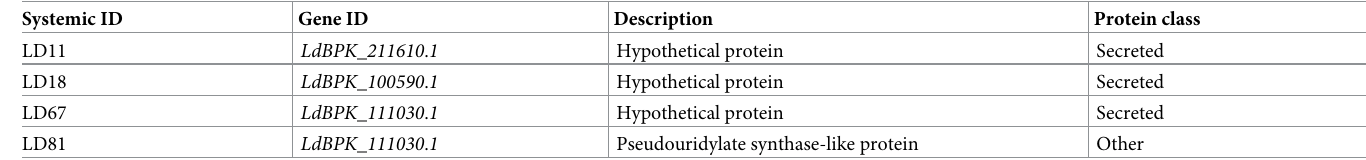
Table 1. A list of genes with evidence of in vitro essentiality from a reverse genetic screen. Genes are listed with their systematic “LD” number, accession identifier, description and protein architectural class information as assigned from SignalP, HMMER and GPI-pred. Systemic ID Gene